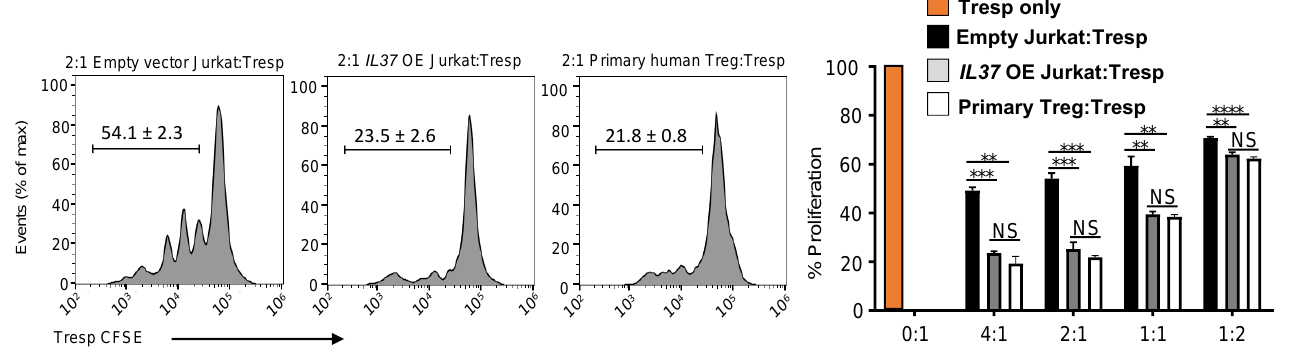
Figure 4. IL-37 overexpressing Jurkat cells are highly suppressive. In vitro T cell suppression assay by vector control and IL37 OE Jurkat cells. Histograms (left) and % proliferation (right) showing division of CFSE-labeled CD4+CD25- T cell responders (Tresp) purified from healthy human donor PBMCs, cultured with anti-CD3 and either vector control Jurkat cells (black bars), IL37 OE Jurkat cells (gray bars), or human primary Treg cells (white bars) at Treg:Tresp ratios of 4:1 to 1:2 for 5 days. Purified Tresp cells without Jurkat cells or Treg cells (0:1) were used as a positive control of Tresp proliferation without suppression (an orange bar). Data represent mean ± s.e.m. NS, not significant ( p > 0.05); ** p < 0.01; *** p < 0.001; **** p < 0.0001 (Student’s t test). Data are representative of two independent